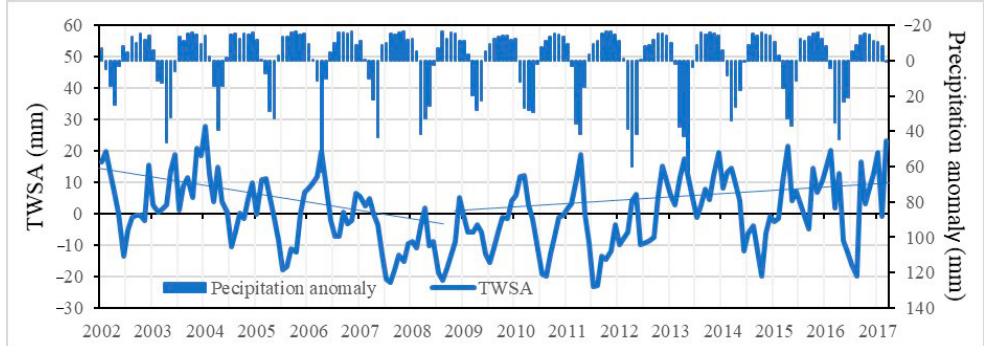
Figure 3. Time series of GRACE − inferred Total Water Storage Anomaly (TWSA) and observed precipitation anomaly for Mongolia from 2002 to 2017.